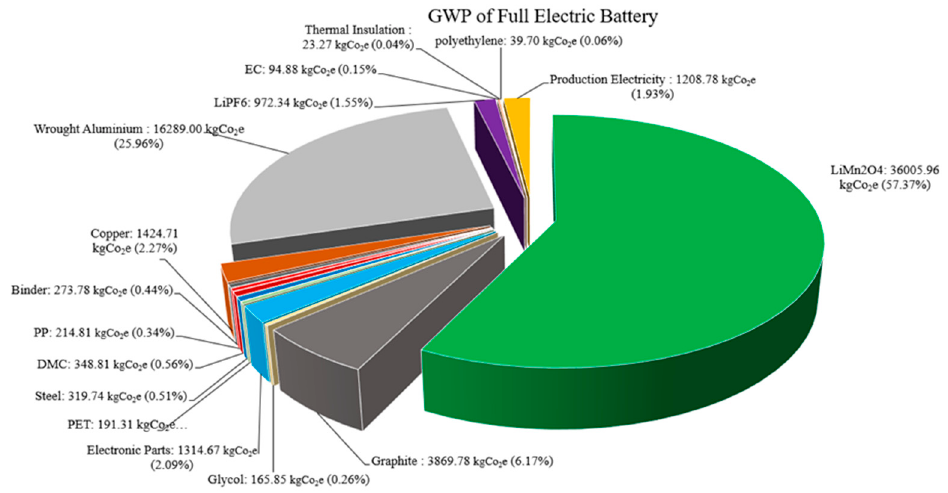
Figure 6. GWP contributions for a full electric battery. Abbreviations: ethylene carbonate (EC), dimethyl carbonate (DMC), polypropylene (PP), polyethylene terephthalate (PET).